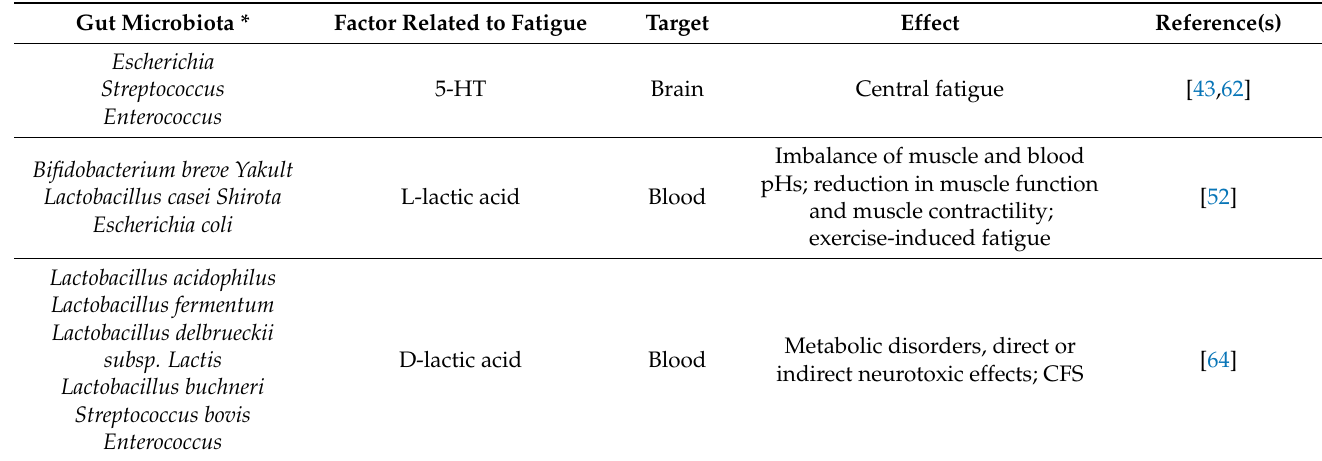
Table 1. The gut microbiota involved in fatigue-induced damage